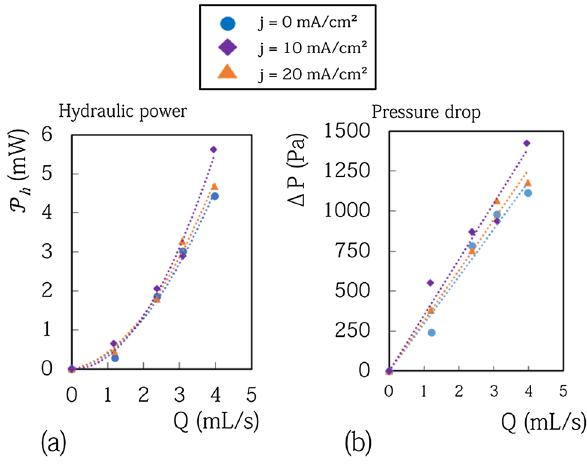
Figure 8. ( a ) Hydraulic power required to flow the electrolyte in the cell for various flow rate and various current density. ( b ) Drop of pressure as a function of the flow rate for various current